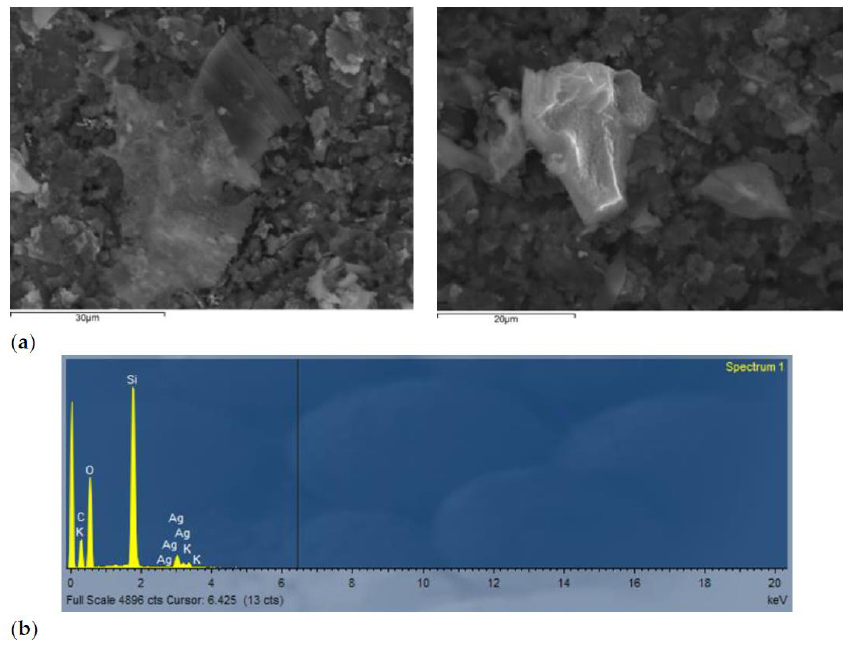
Figure 1. SEM images of RHB700 ( a ) and EDX analysis ( b ).